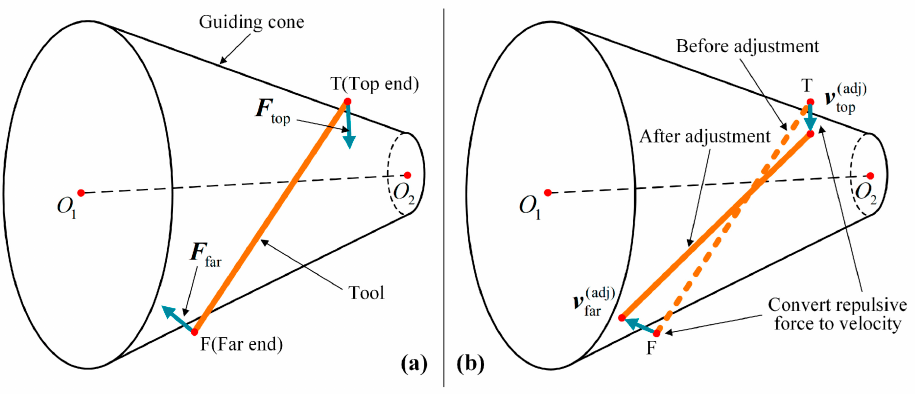
Figure 8. Two-Point Adjustment: ( a ) Two-point force; ( b ) Repulsive force convert to velocity.